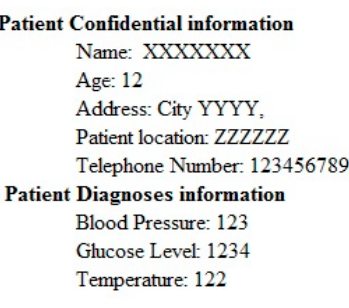
Figure 3. Image of patient information.